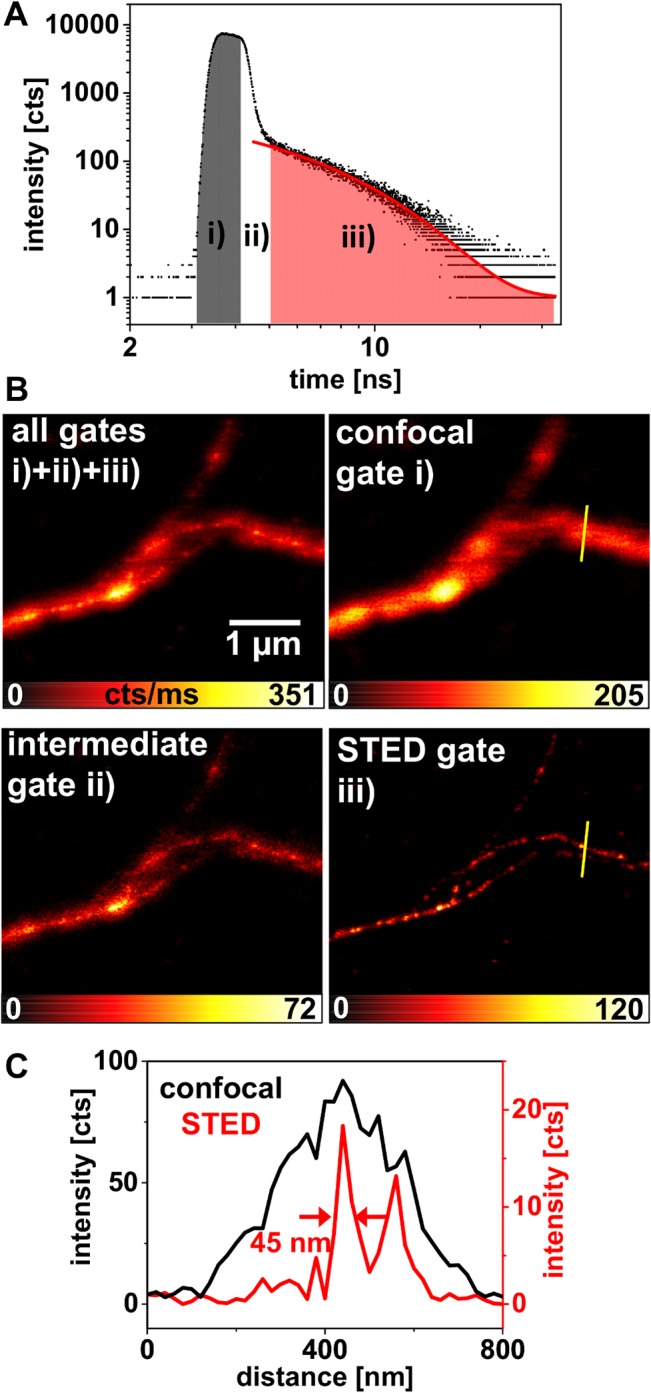
TCSPC approach for time-gated STED imaging.(A) Double-logarithmic TCSPC histogram of the fluorescence signal of the F-actin marker Abberior STAR635-phalloidin under ps-pulsed excitation and ps-pulsed stimulated emission. Three time gates are indicated: gate i) contains the fluorescence emitted by the labeling dye before application of the STED pulse, the gate ii) intermediate gate contains residual fluorescence emitted during the stimulated emission process, and the gate iii) STED gate contains the fluorescence from the very center of the STED doughnut after the completion of the stimulated emission process. (B) Fluorescence images of STAR635-phalloidin labeled in vitro F-actin obtained from the different time gates i), ii), iii), and the sum of all three time gates, as indicated in (A). Gate i) comprises photons with the confocal spatial information of the structure, gate iii) photons with the diffraction-unlimited STED information, and gate ii) contains a mixture of fluorescence photons that differ in the spatial information they carry. (C) Profile plots along the yellow line in the confocal and the STED image in (B), indicating the same F-actin structure with different spatial resolutions.